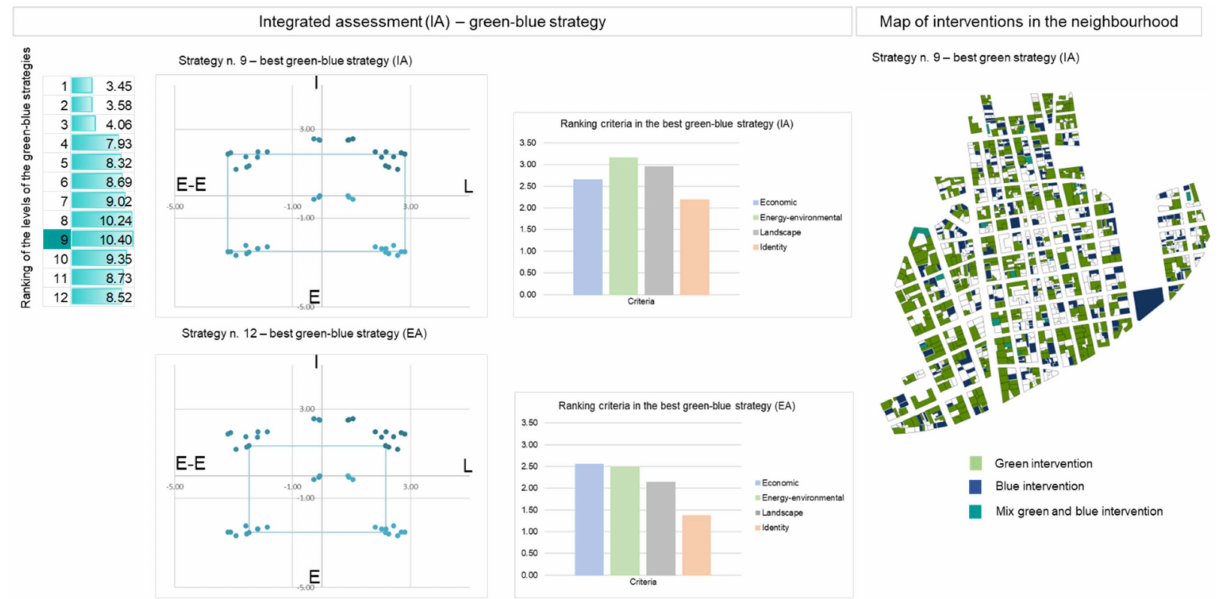
Figure 9. Ranking of the levels of the green-blue strategy based on the aggregate assessment; comparison between the two levels of the strategy in economic terms and the integrated assessment; visualization of the ranking of the criteria for the best economic level and of the integrated evaluation; map displaying the best level of the green-blue